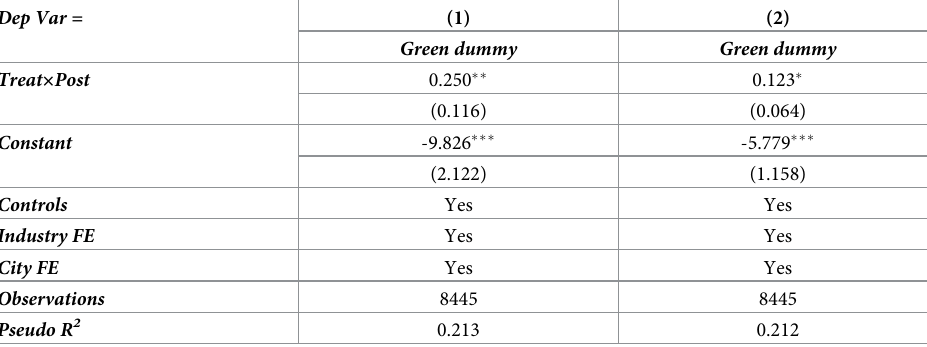
Table 6. Robust regression results for Logit and Probit